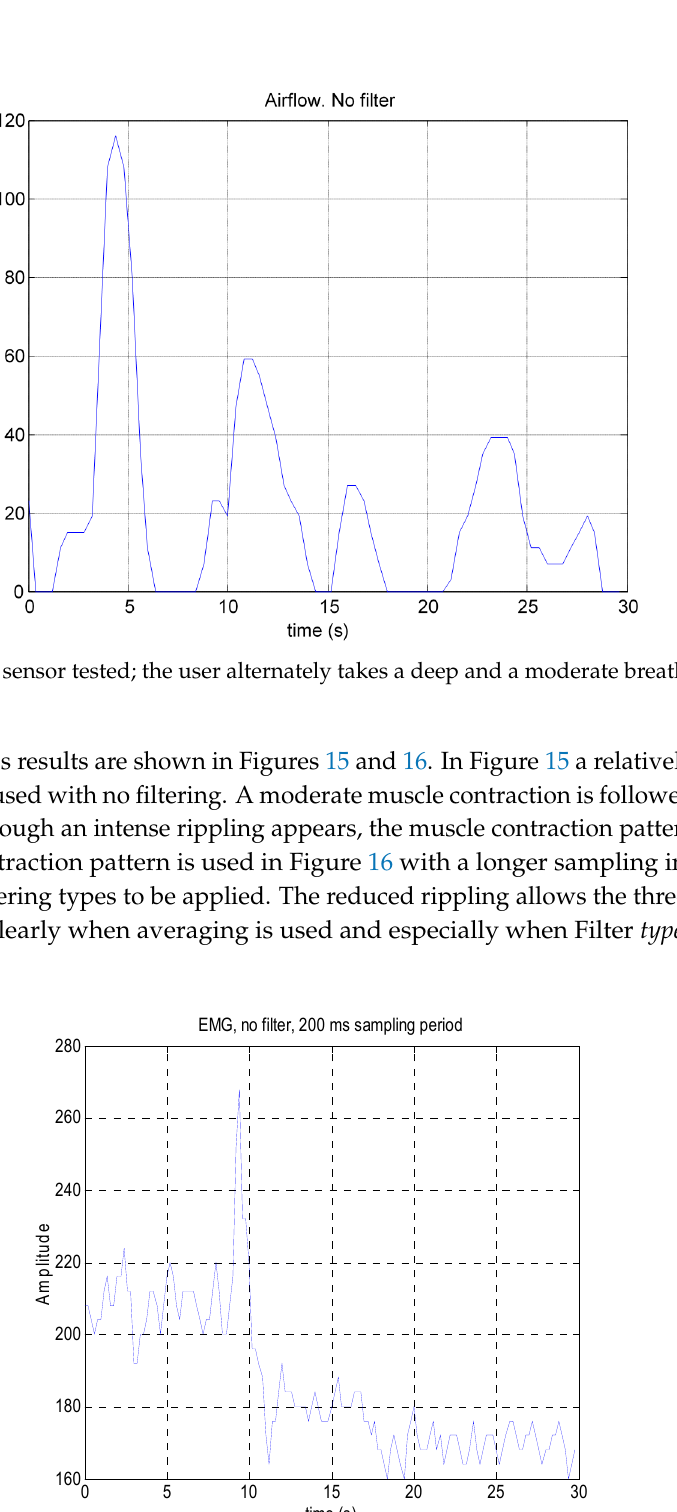
Figure 13. Airflow sensor tested; the user takes alternately a deep and a moderate breath. Filter type 1 was applied.